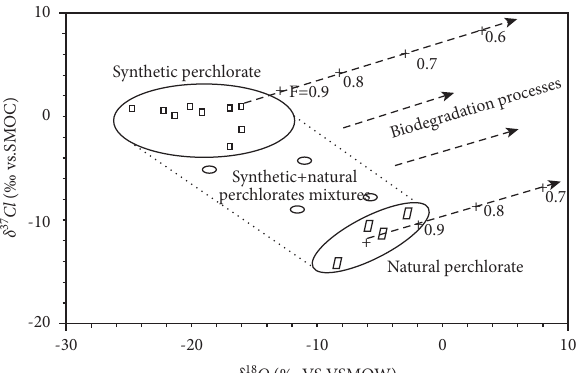
Figure 3: Schematic relation between characteristic δ 37 Cl and δ 18 O values (per mil) of synthetic and natural perchlorate samples during biodegradation processes